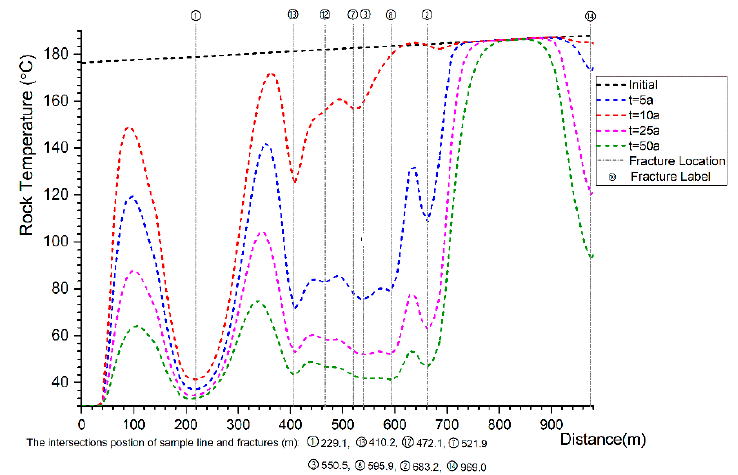
Figure 13. Temperature evolving in sample line 1 at injection rate of 136.6 kg/s.